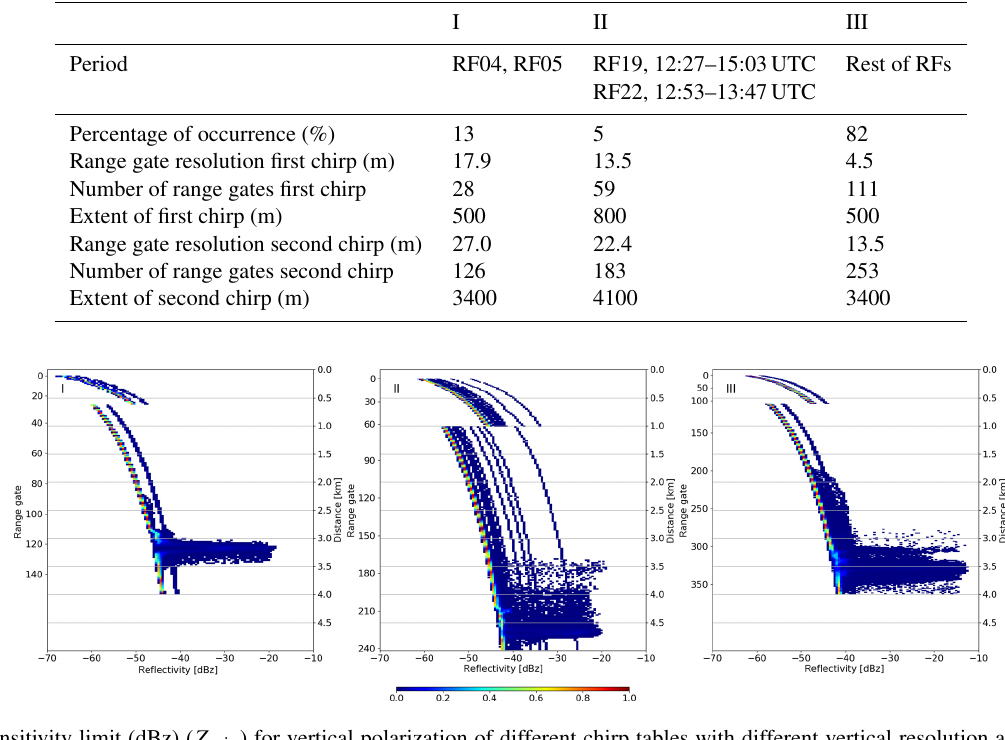
Figure 1. Sensitivity limit (dBz) ( Z min ) for vertical polarization of different chirp tables with different vertical resolution as a function of distance from the aircraft (secondary y axes) for the three settings used during ACLOUD. The vertical resolution increases from left to right (I to III) with increasing number of range gates: (I) 154 range gates, 25 May, 08:58–12:19UTC, RF05; (II) 242 range gates 23 June,